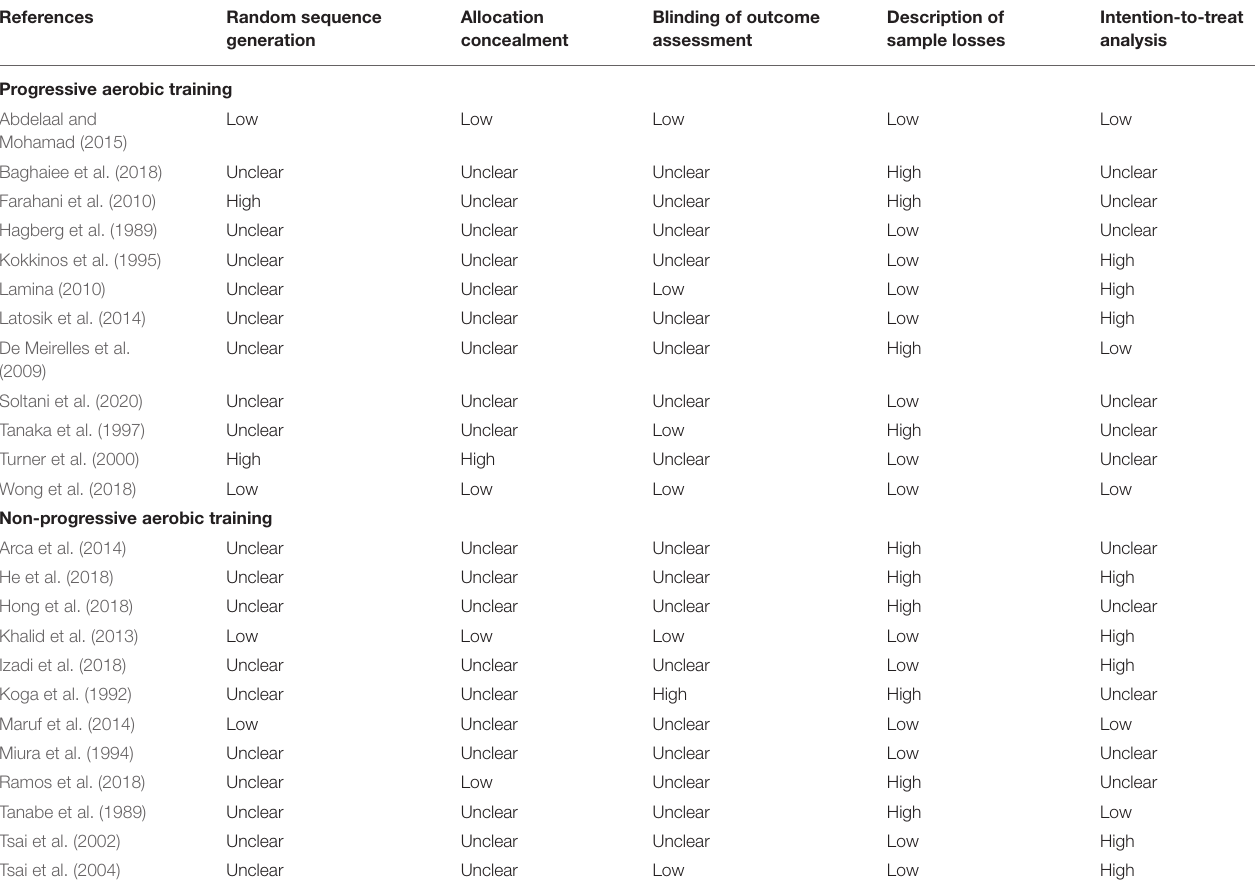
TABLE 3 | Risk of